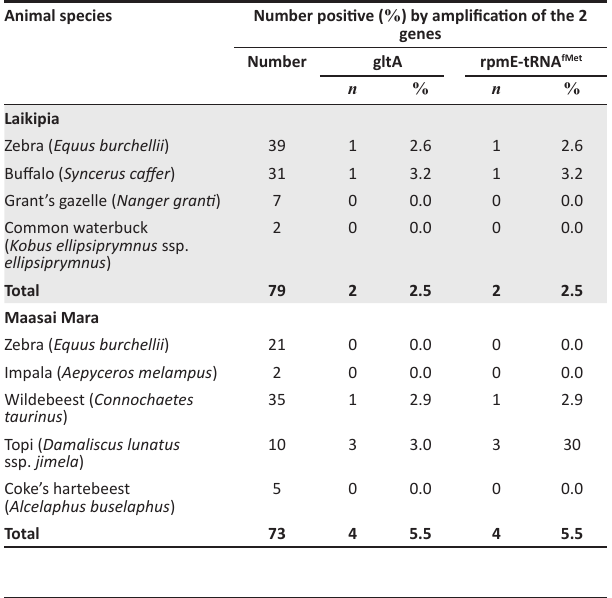
TABLE 3: Animals species sampled and prevalence of spotted fever group rickettsioses. Animal species Number positive ( % ) by amplification of the 2